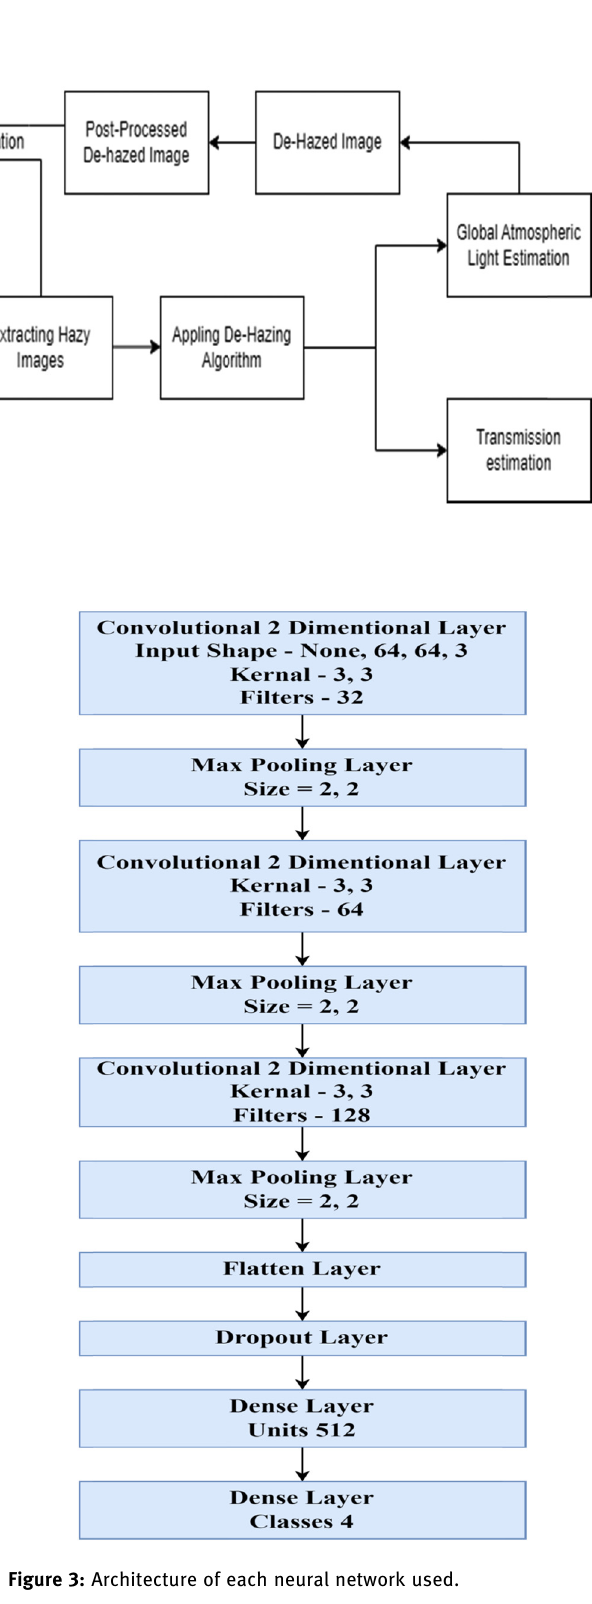
Figure 3: Architecture of each neural network